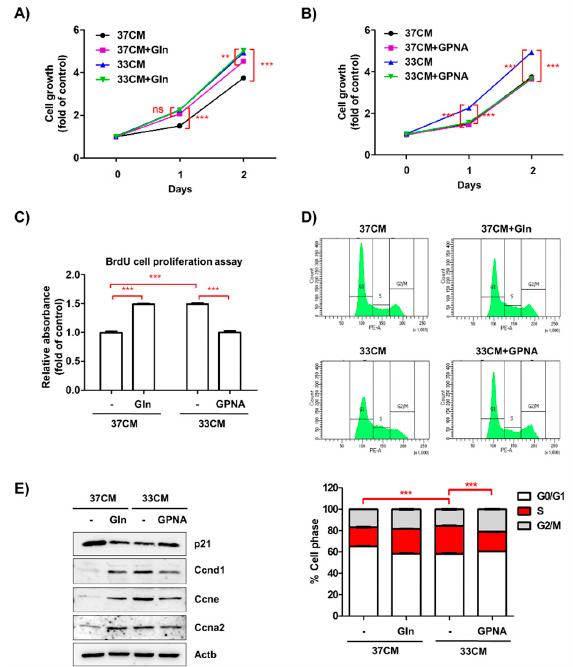
Figure 6. L - γ -Glutamyl-p-nitroanilide (GPNA) suppressed the growth of cancer cells induced by macrophages exposed to low temperature. ( A , B ) LLC cells were incubated with RAW264.7 CM every day for 48 h, with the addition of 1 mM glutamine (+Gln) or GPNA (+GPNA), for panels A and B, respectively. The growth of LLC cells was examined using an MTT assay. ( C ) The effects of Gln or GPNA treatment on the proliferation of LLC cells in the presence of CM from RAW264.7 cells were analyzed using a BrdU incorporation assay. ( D ) LLC cells (5 × 10 4 cells/58 cm 2 ) were incubated with RAW264.7 CM for 24 h. The cell cycle stage was determined by fluorescent-activated cell sorting (FACS) analysis using propidium iodine (PI) staining. Representative histograms of the cell cycle distribution of LLC cells are shown. ( E ) Western blotting analysis results of p21, cyclin D1, cyclin E, and cyclin A2 expression in LLC cells. Actin was used as a loading control. The results are expressed as the mean ± SD. ** p < 0.01 and *** p < 0.001 compared between two groups. ns means no